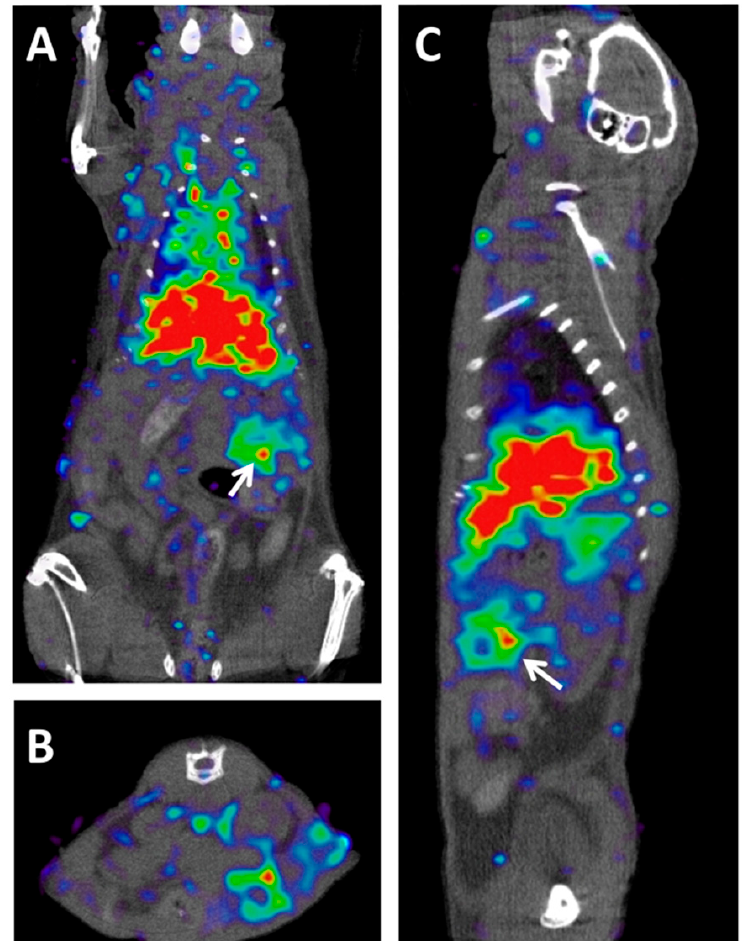
Figure 5. ImmunoPET–CT of MT1-MMP metalloproteinase in a preclinical model of PDAC. ( A ) Coronal, ( B ) axial, and ( C ) sagittal views of fused Immuno-PET and CT images of an orthotopic pancreatic patient-derived xenograft mouse. White arrows indicate tumor location. The imaging probe used was [ 89 Zr]Zr-DFO-LEM2/15, a mAb developed against the MT1-MMP metalloproteinase [107]. Owing to the central role that this metalloproteinase plays in collagen-induced gemcitabine resistance, this probe could be used for the early prediction of resistance to gemcitabine in metastatic PDAC